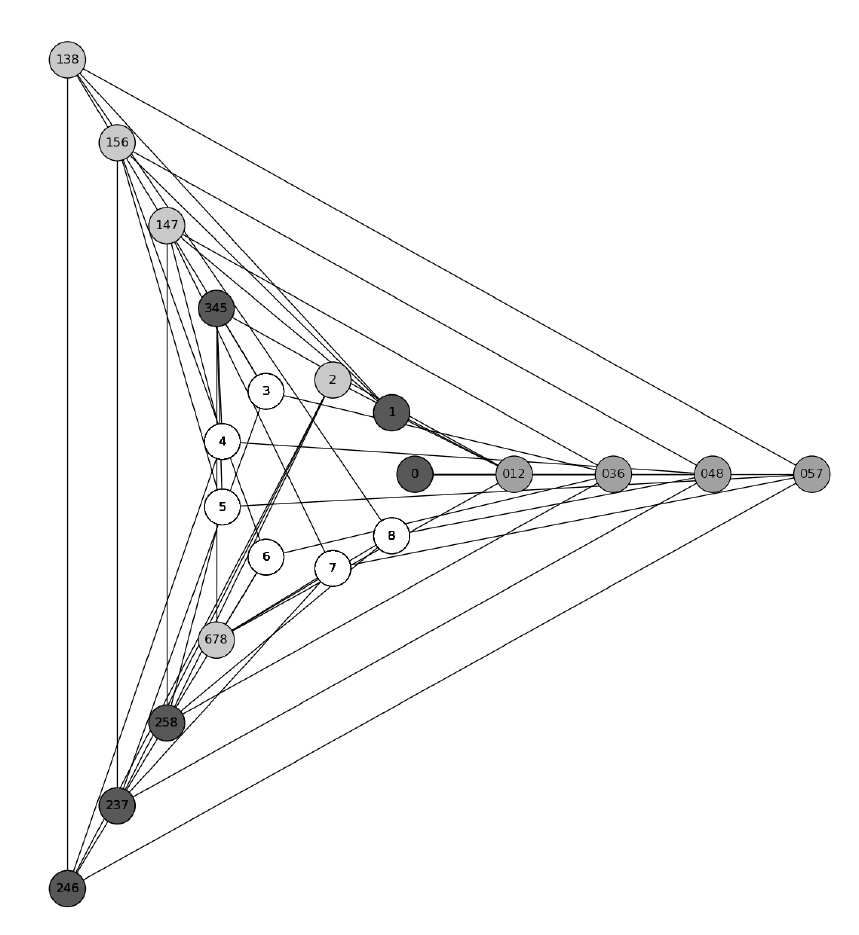
Figure 1. One possible presentation of the orthogonality graph for the Hesse SIC states and their associated MUB. Each vertex stands for a quantum state, and vertices are linked by an edge if those states are orthogonal. The nine circles near the center, labeled by single-digit numbers, denote the SIC states. The other vertices, labeled by three-digit sequences, stand for the MUB states. Each of the four nested triangles is an orthonormal basis, e.g., { s 012 , s 345 , s 678 } . The graph is colored such that no two adjacent vertices share the same